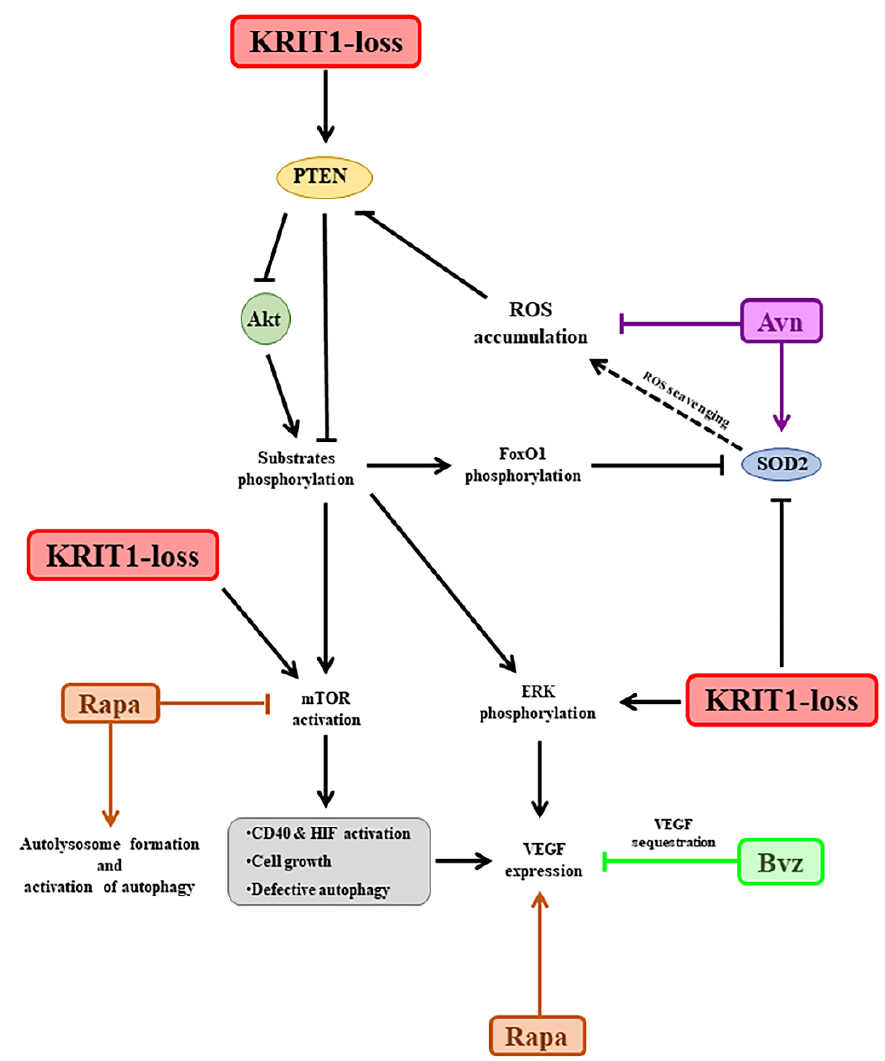
Figure 5. Schematic representation of the molecular targets considered in order to develop the proposed nanomedicine-based combinatorial therapeutic approach for CCM disease. The most significant results have been obtained by targeting the oxidative stress with lipid nanoemulsions containing avenanthramide, both alone and in combination with rapamycin. Conversely, the efficacy of rapamycin as an autophagy promoter needs to be improved in the nanoemulsion, and the effect of the bevacizumab-loaded nanoemulsion in rescuing the abnormal angiogenesis looks contradictory, probably due to the in vitro model employed. Abbreviations: Avn: yeast avenanthramide I; Akt: protein kinase B; Bvz: bevacizumab; CCM: cerebral cavernous malformation; CD40: cluster of differentiation 40; ERK: extracellular-signal-regulated kinase; FoxO1: forkhead box class O1; HIF: hypoxia-induced factor; KRIT1: Krev interaction trapped protein 1; mTOR: mammalian target of rapamycin; PTEN: phosphatase and tensin homolog; Rapa: rapamycin; ROS: reactive oxygen species; SOD2: superoxide dismutase 2; VEGF: vascular endothelial growth